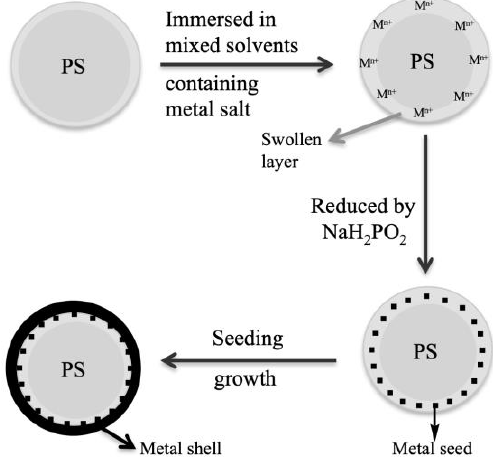
Figure 7. Schematics of coating polystyrene colloids with a metal shell. Redrawn by adaptation from Reference [56]. Copyright (2004) John Wiley and Sons.